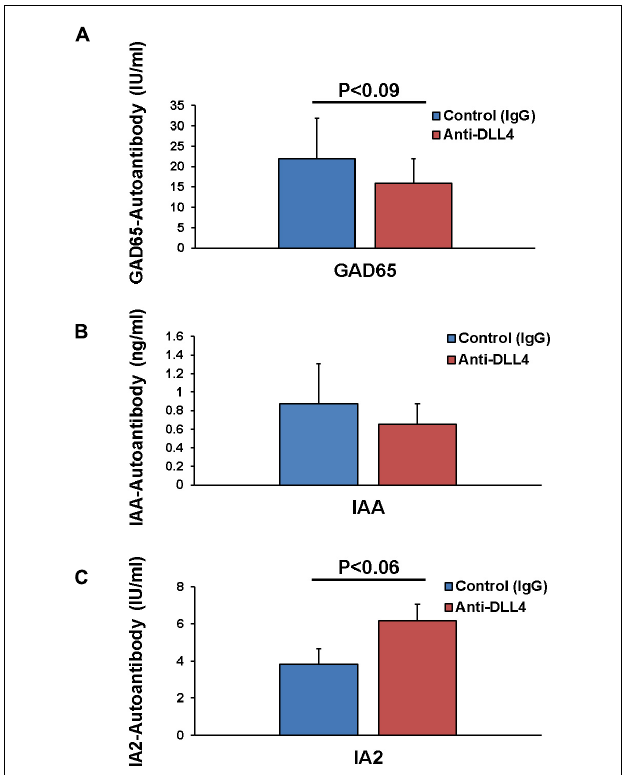
FIGURE 5 | Anti-DLL4 reduces antigen specific autoantibodies. Post sacrifice of mice, sera were subjected for autoantibody analysis. Anti-GAD65 antibodies in serum were measured in anti-DLL4 and control IgG treated groups ( n = 4 per group) (A) . Anti-insulin antibodies were also measured using mouse insulin autoantibody (IAA) ELISA in anti-DLL4 and control IgG treated groups (B) with a positive predictive value range of 0.16–10 ng/ml ( n = 4 per group). Anti-IA-2 autoantibodies were also measured ( n = 4 per group) using human IA-2 autoantibody (IA-2Ab) ELISA in anti-DLL4 and control IgG treated groups (C)